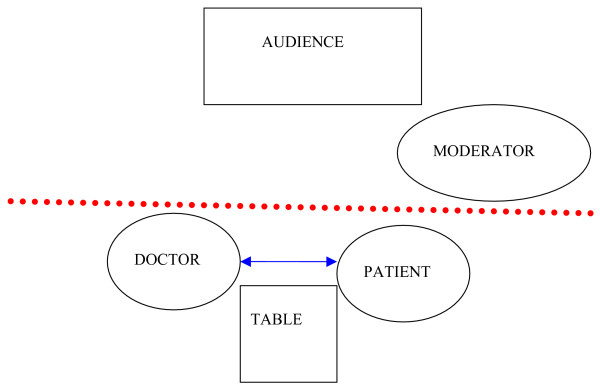
Location 1. The arrows indicate the direction of the communication. The fourth wall is transparent for the audience, opaque for the actors.